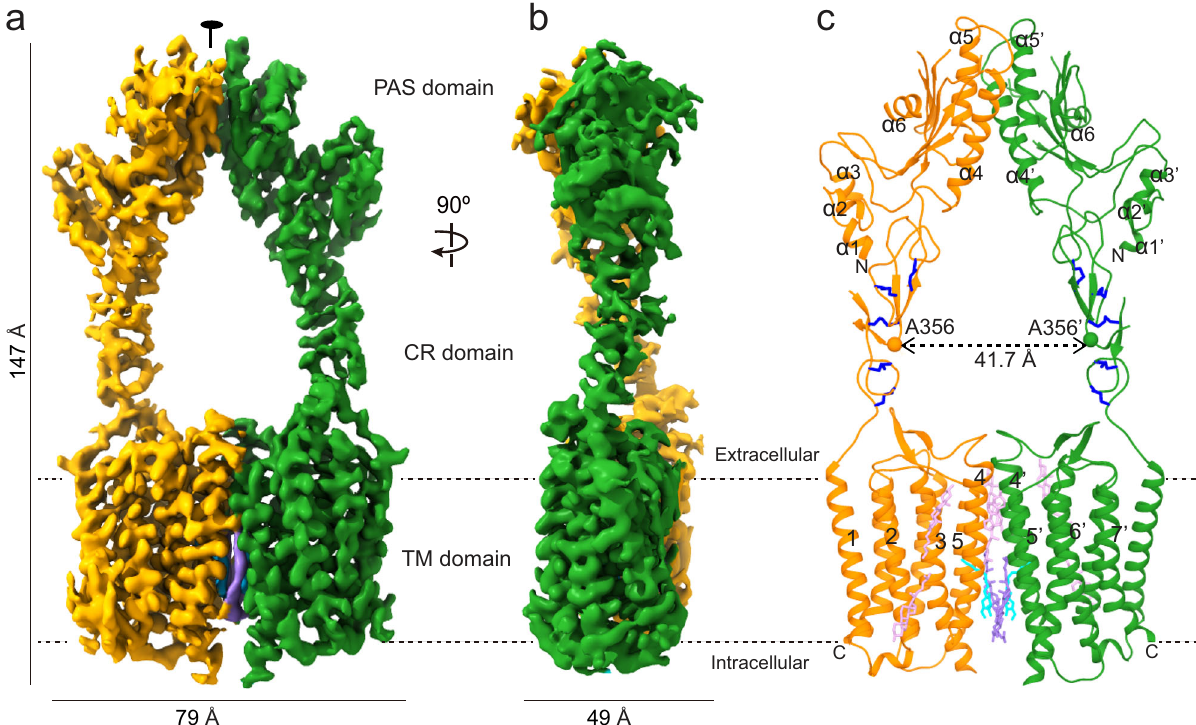
Fig. 1 Cryo-EM structure of GPR158. a , b Cryo-EM maps of the GPR158 homodimer in orthogonal views. c Model of GPR158 colored the same as in a . CHS, OG, and cholesterol molecules are represented as purple, sky blue, and pink sticks, respectively. Disul fi de bonds are shown as blue